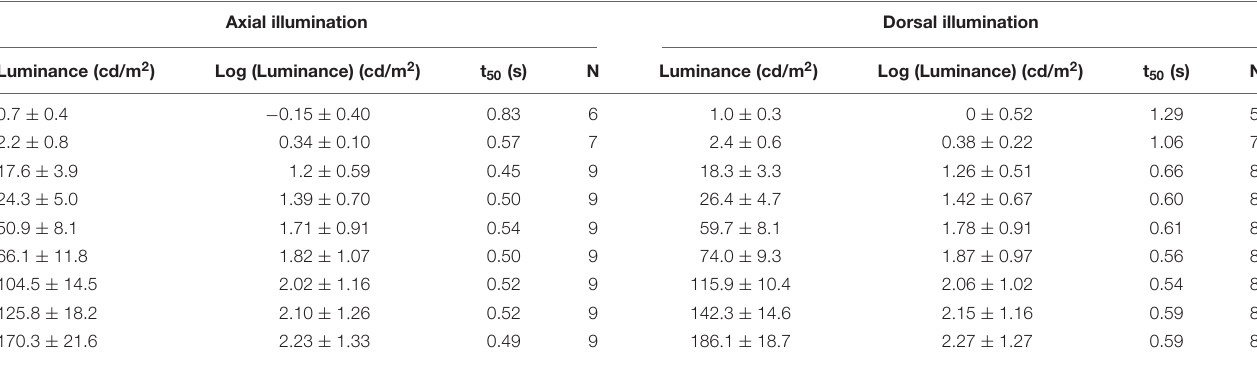
TABLE 2 | Light levels used to elicit a pupil response of Octopus vulgaris during axial and dorsal illumination average luminance as well as log (luminance) in cd/m 2 ± SD) as well as the t 50 -values (in s) determined during the respective pupillary light reaction with the number of measurements (N) performed to determine the t 50 -value. Axial illumination Dorsal illumination Luminance (cd/m 2